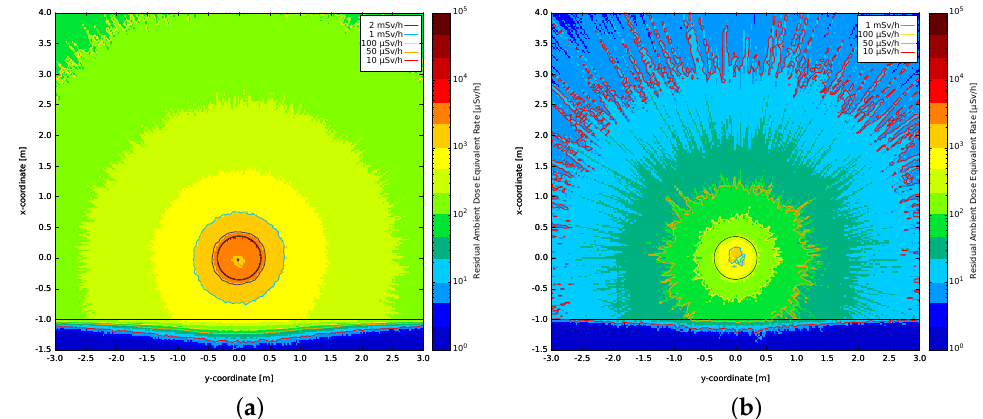
LHC TDE PIE - Configuration A (Dec. 2021) - Average over LDG section (z=110/430)